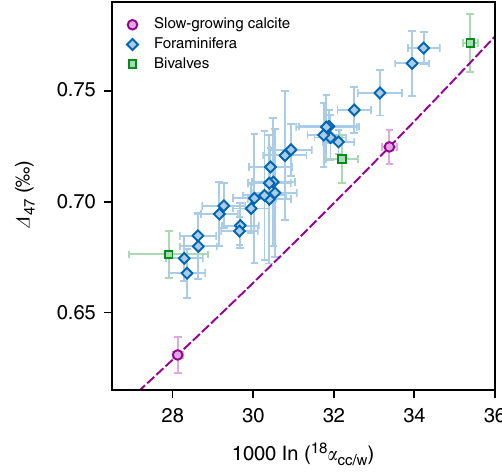
Fig. 3 Equilibrium versus biogenic calcites in 18 α cc/w − Δ 47 space. Combining the 18 O/ 16 O and Δ 47 thermometers requires some constraints on water δ 18 O values, but makes it possible to test whether carbonates precipitated in isotopic equilibrium even if crystallization temperature is unknown. Dashed line corresponds to the equilibrium baseline de fi ned by Eqs. (1) and (3). Error bars represent 95% con fi dence